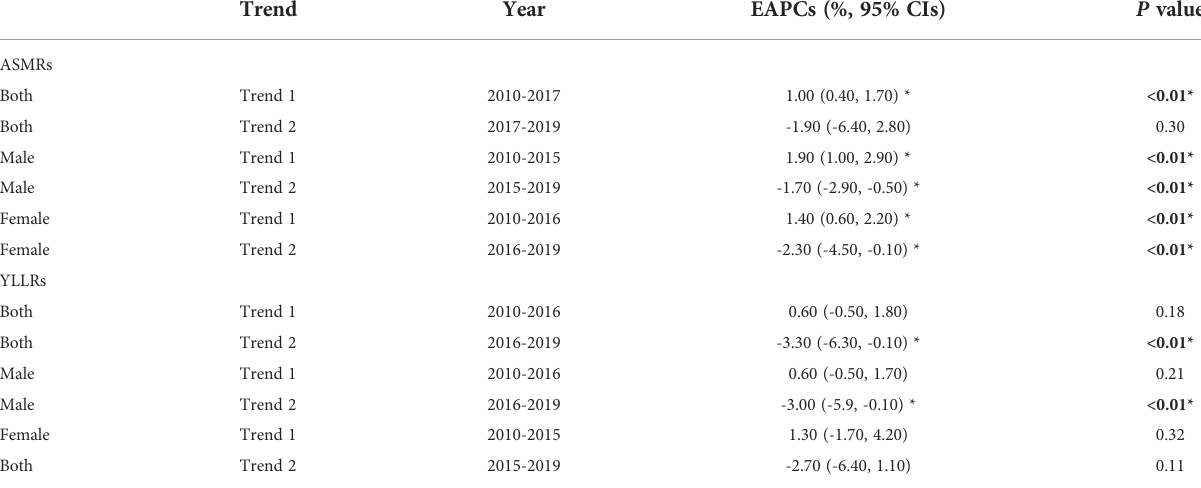
TABLE 2 The Joinpoint regression models for ASMRs and YLLRs of cancer in Wuhan, 2010-2019.